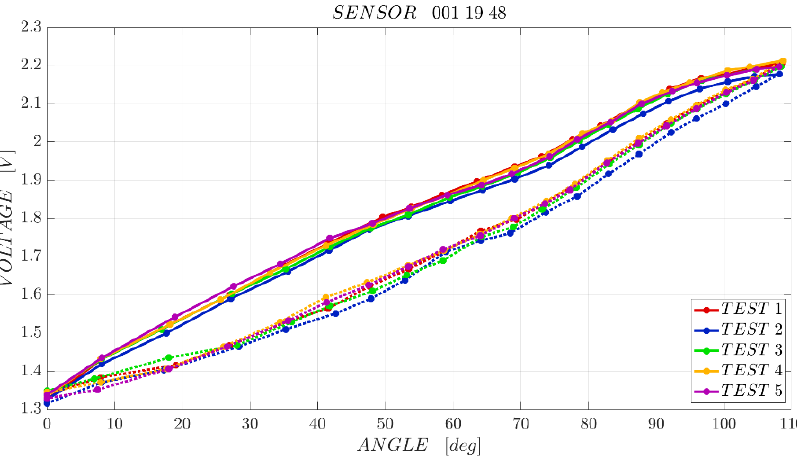
Figure 18. Example of sensor characterization with R = 47 k Ω .